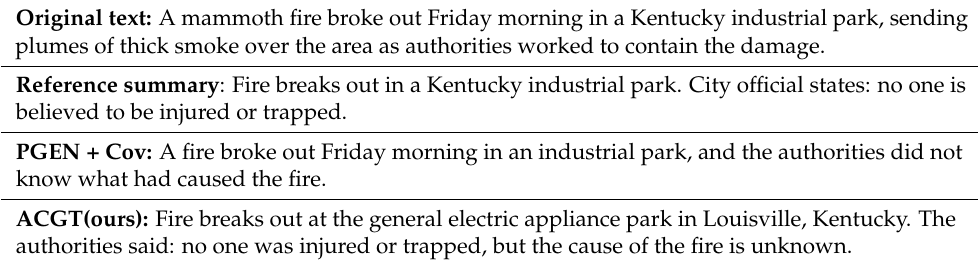
Table 6. Example of summaries generated on CNN/DM dataset.